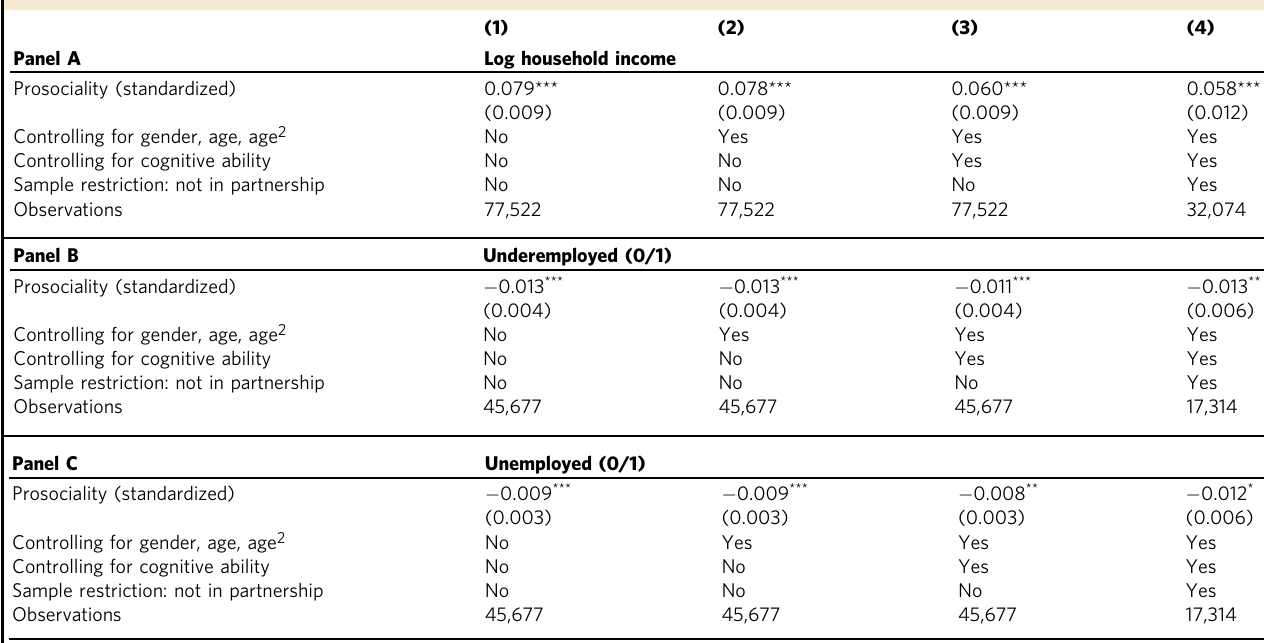
Table 1 Prosociality predicts labor market